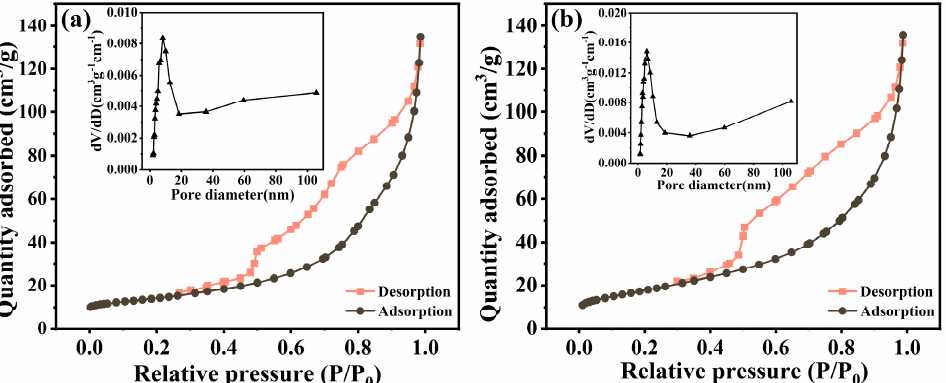
Figure 6. Typical N 2 adsorption–desorption isotherm and pore size distribution plots (inset) of ( a ) In 2 O 3 and ( b ) 5-rGO/In 2 O 3 .